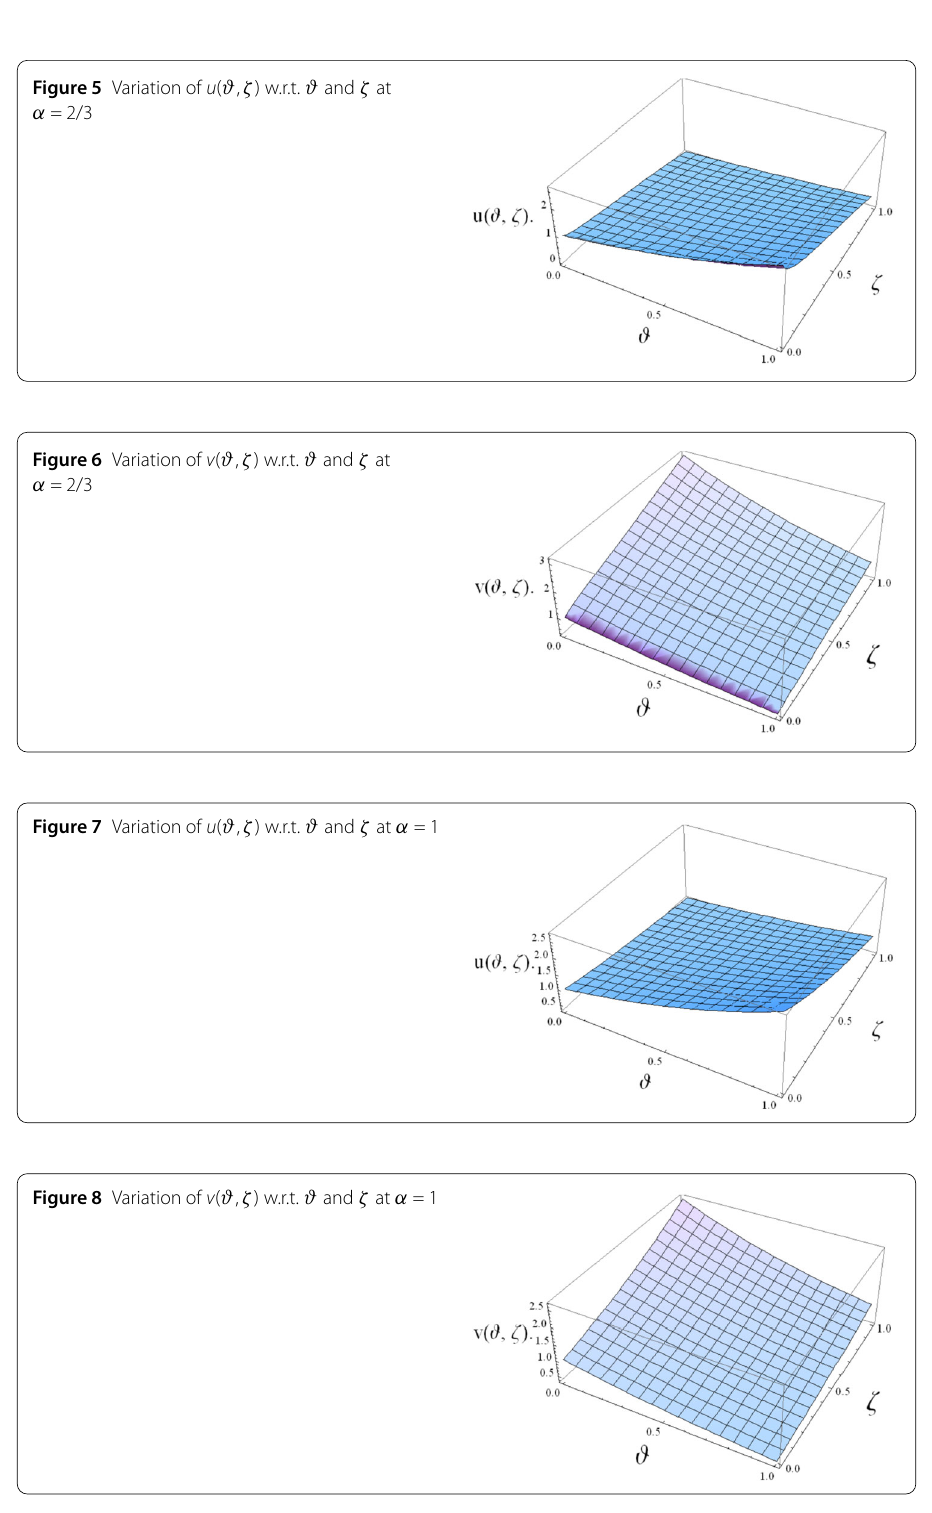
parameter α . Two- and three-dimensional graphical demonstrations ensure the high ac- curacy of the generated results using RPSM by involving four iterations only. Nevertheless, the numerical results can be generated more precisely by computing additional iterative